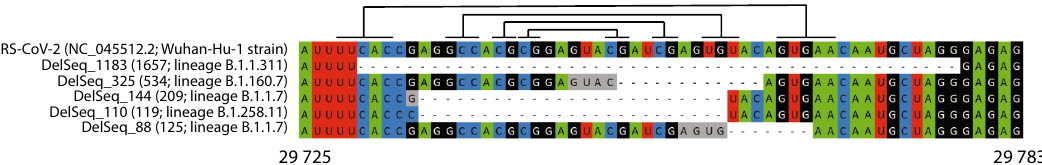
Figure 2. Alignment of the five most common SARS‑CoV‑2 s2m indel mutants in the GISAID database. Brackets indicate stem‑forming regions as described for SARS‑CoV 9 and the Wuhan‑Hu‑1 strain has been included as a reference (nucleotide positions below indicate Wuhan‑Hu‑1 genome coordinates). Number of instances in the GISAID database and dominant lineage have been indicated (parenthesis after sequence name) and grey boxes show nucleotide(s) positions where there are multiple equally parsimonious ways of making the